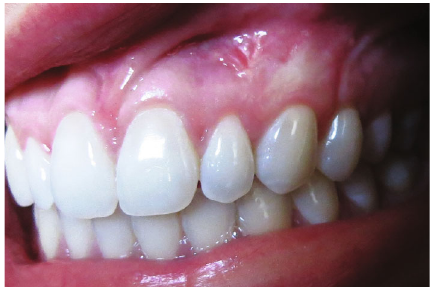
Figure 14: 1-year postoperative